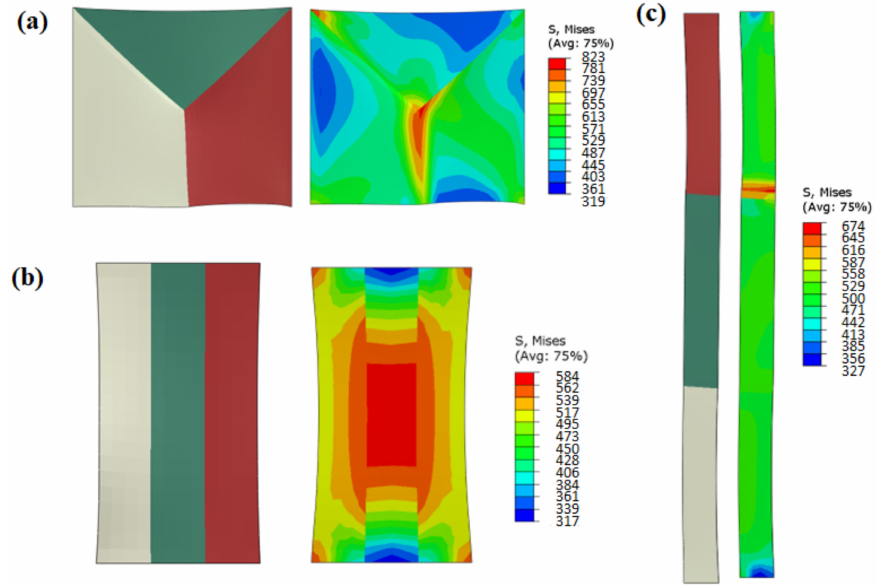
Figure 9. Effective stress of different grain boundary morphologies: ( a ) triple-junction GB of EG; ( b ) parallel GB of CG; ( c ) transverse GB of